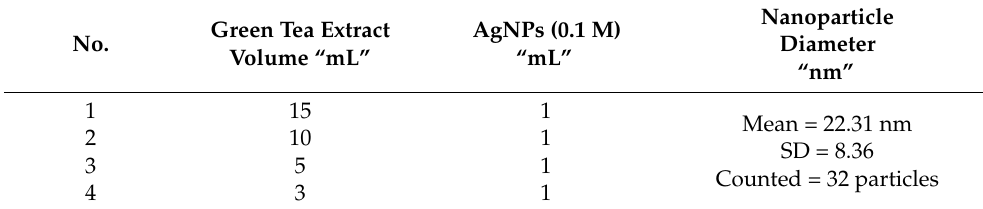
Table 1. Designated Tea Silver Nanoparticles (TAgNPs) (20 g/L).